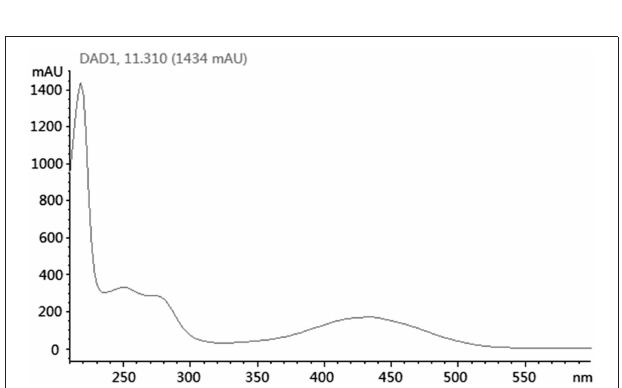
FIGURE 4 | UV/vis spectra of selected peak at t R